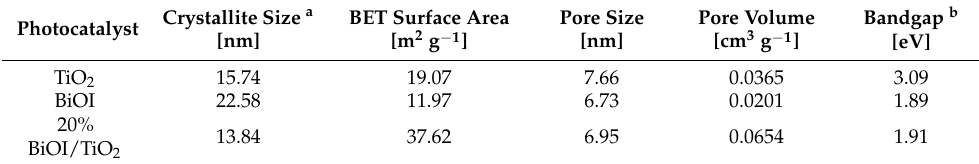
Table 1. Structural and electronic properties of the synthesized semiconductor photocatalysts. Crystallite Size a Photocatalyst [nm]